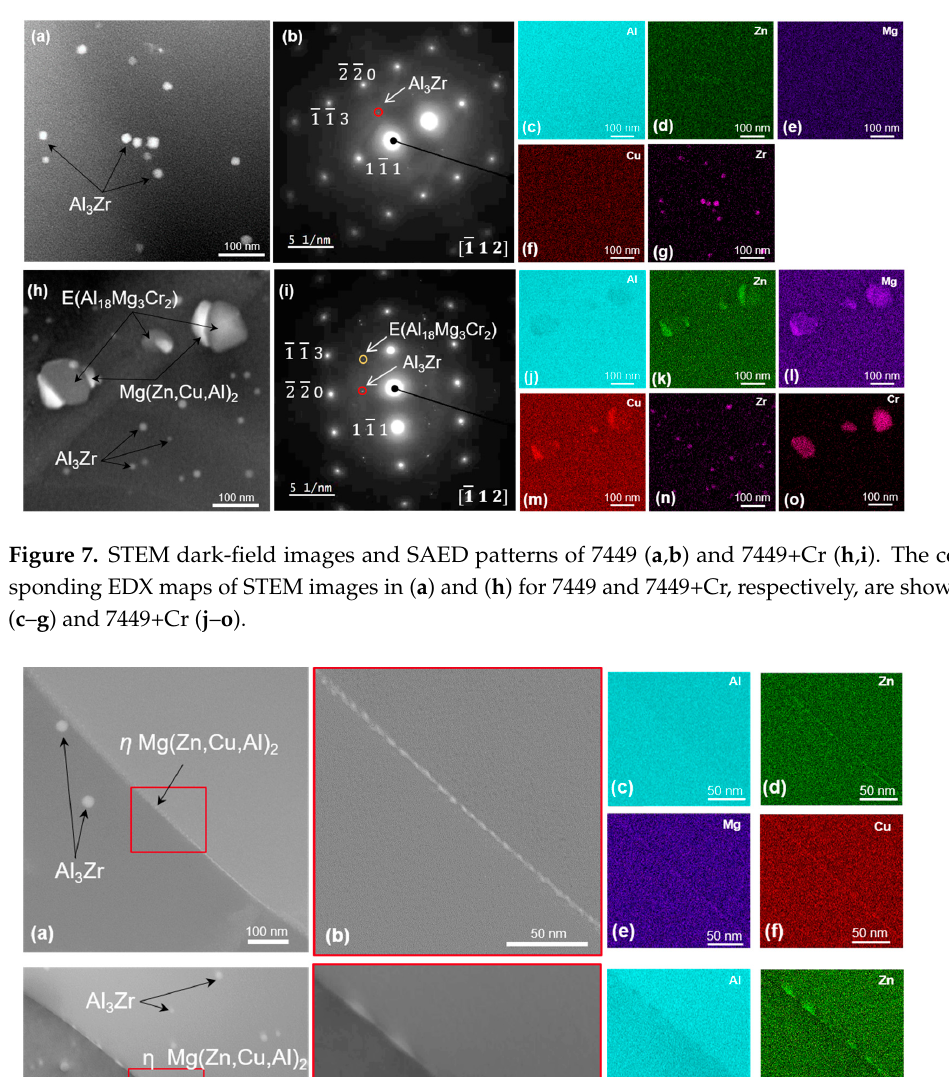
Figure 9. STEM dark-field images and EDX maps of alloys in T6 state: ( a – f ) 7449 and ( g – l ) 7449+Cr. The red boxes indicate the region of interest for EDX mapping.